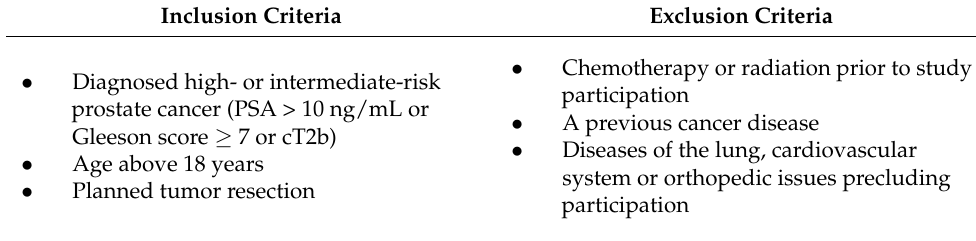
Table 3. In- and exclusion